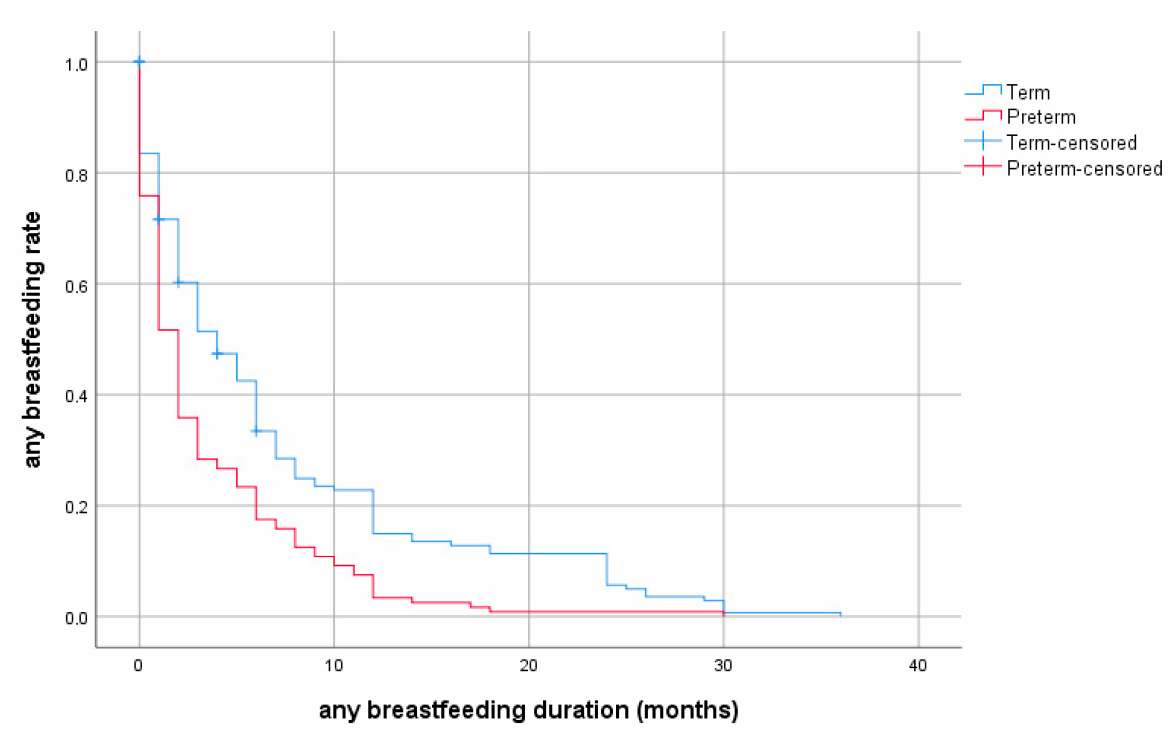
Figure 3. Probability of any breastfeeding depending on duration (months, discrete survival curves) according to